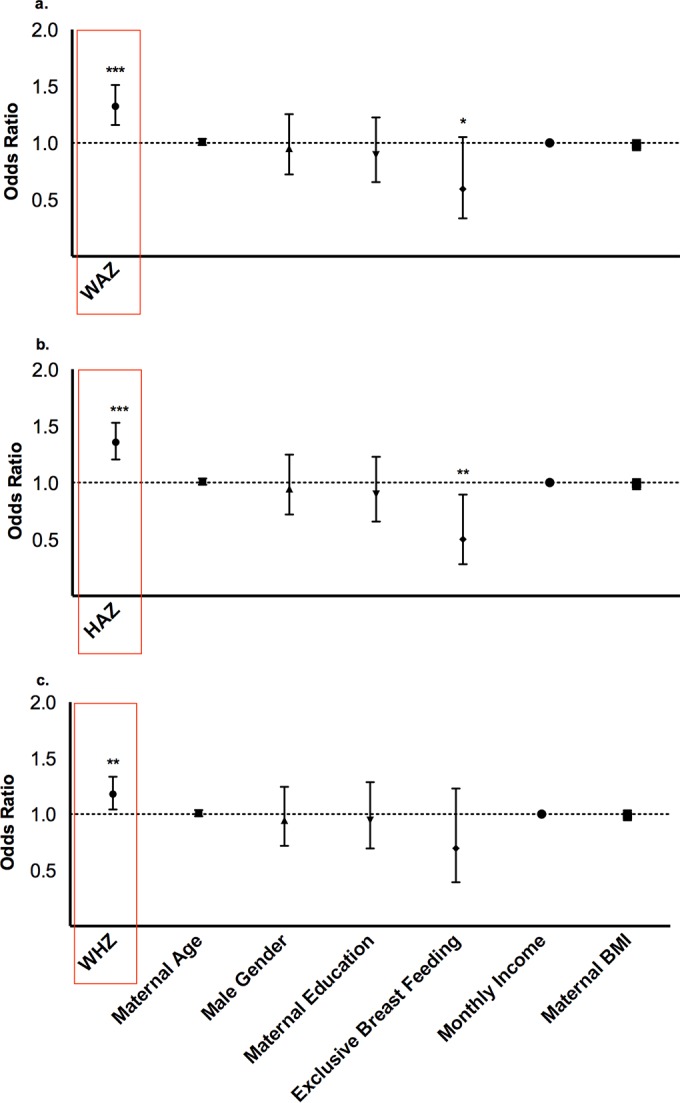
Malnutrition, stunting, and wasting reduce the risk of rotavirus infection in the first 3 years of life. Odds ratios for rotavirus diarrhea from longitudinal models of anthropometric Z-scores, boxed in red, are plotted with 95% confidence intervals. Weight-for-age (a), height-for-age (b), and weight-for-height Z-scores (c) were measured at 3-month intervals. Models for each anthropometric measure were adjusted for maternal age, infant sex, maternal education, monthly income, and maternal BMI. Exclusivity of breastfeeding during each interval was included as a time-varying covariate in each model. * indicates the level of significance, with ** indicating a P value of <0.001 and ** a P value of <0.0001.